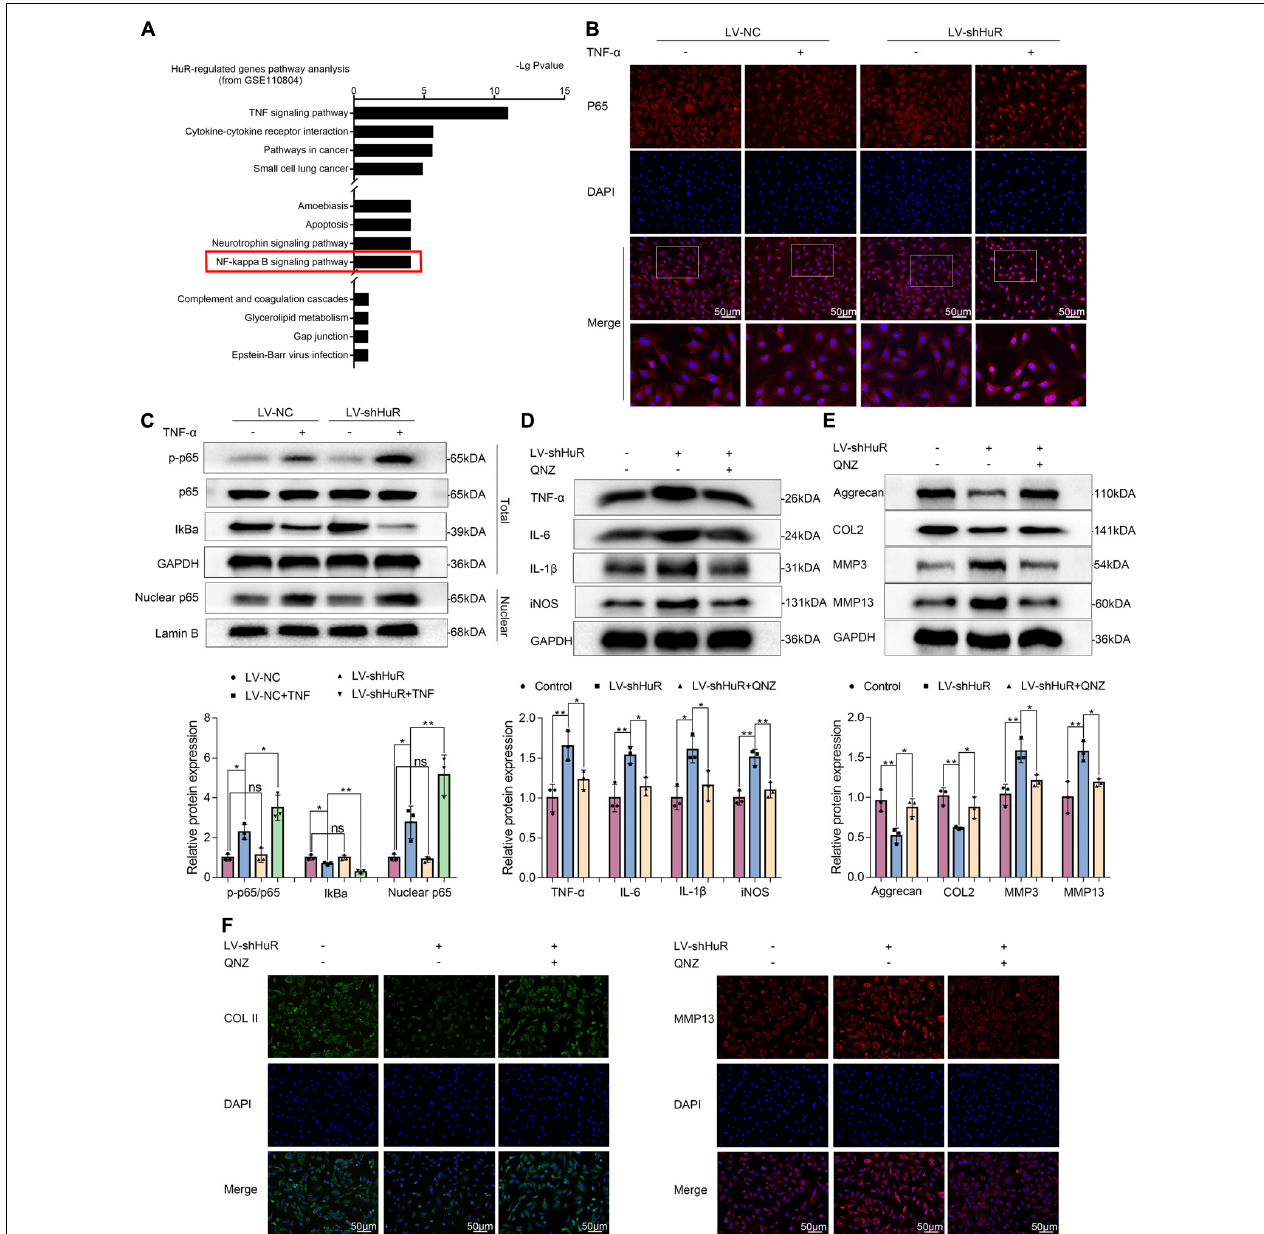
FIGURE 3 | HuR regulates NF- κ B signaling pathway in TNF- α -treated NP cells. The cells were transfected with LV-shHuR before TNF- α treatment. (A) The KEGG pathway analysis included HuR-regulated genes (top 1000), from GSE110804, and the regulation of NF- κ B signaling pathway was put forward. (B) The p65 was detected by immunofluorescence combined with DAPI staining for the nuclei (scale bar: 50 µ m). (C) The protein expression of p-p65, p65, I κ B α , and nucleus p65 was detected by Western blot in the NPCs, with or without TNF- α treatment and added lentivirus. (D) The protein expression of IL-6, IL-1 β , TNF- α , and iNOS was detected by Western blot, with or without LV-shHuR lentivirus and added NF- κ B signaling pathway inhibitor QNZ. (E) The protein expression of Aggrecan, COL2, MMP3, and MMP13 was detected by Western blot. (F) The COL2 and MMP13 were detected by immunofluorescence combined with DAPI staining for nuclei (scale bar: 50 µ m). All data were shown as mean ± SD ( n = 3). * p < 0.05, ** p <